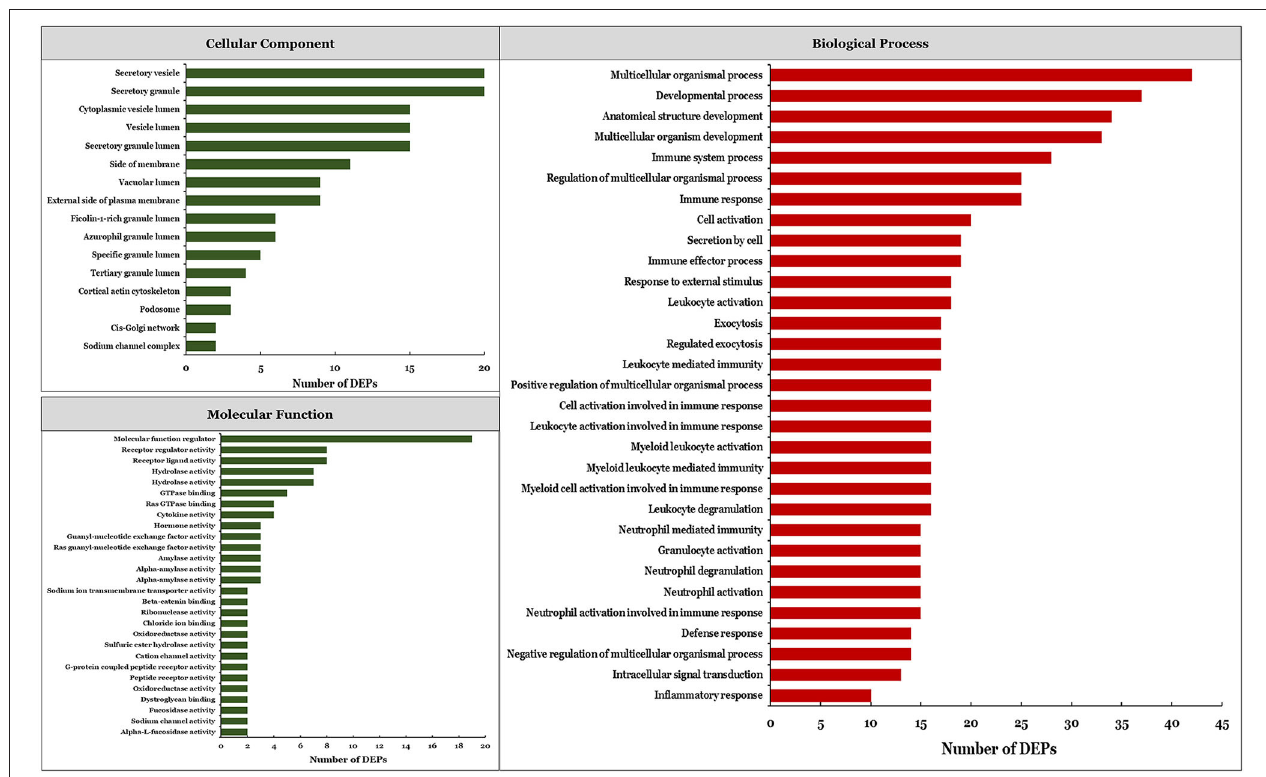
FIGURE 2 | Significantly enriched GO terms based on